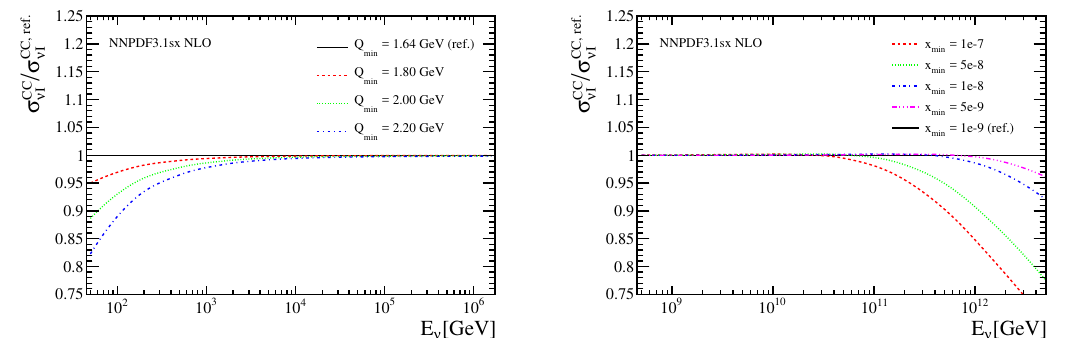
Figure 3 . The dependence of the total CC neutrino-isoscalar cross-section, eq. (2.4), with respect to variations of the lower integration limits Q 2 default (ref.)